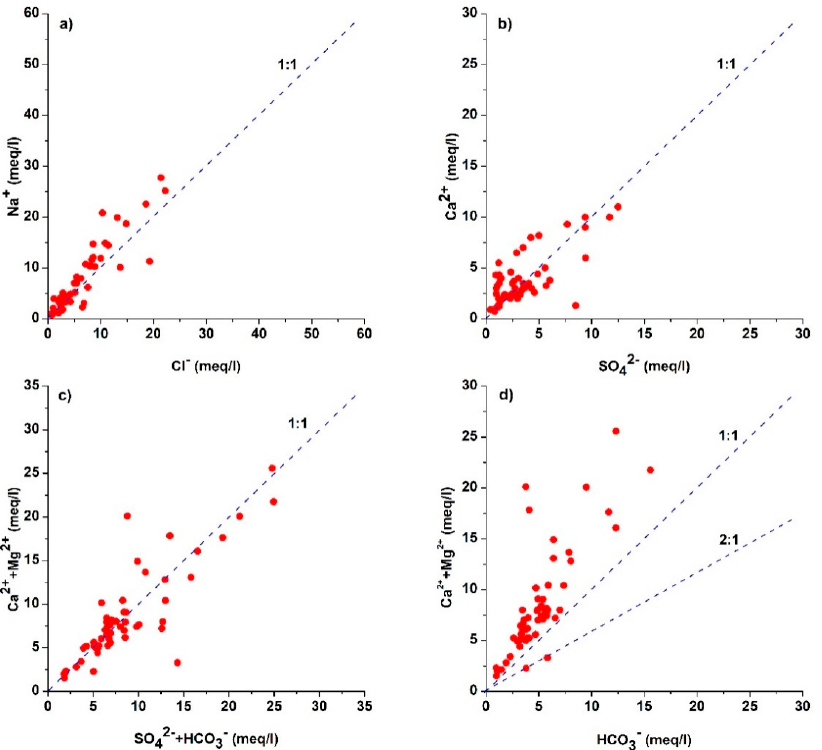
Figure 4. Relationship between ions ( a ) Na + versus Cl − ( b ) Na + versus TZ + ( c) Ca 2+ + Mg 2+ versus SO 42 − + HCO 3 − ( d) Ca 2+ versus SO 42 .